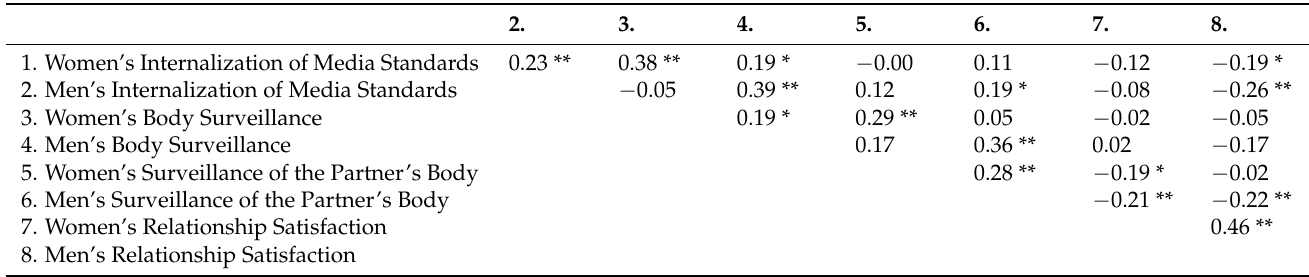
Table 1. Pearson’s correlations between